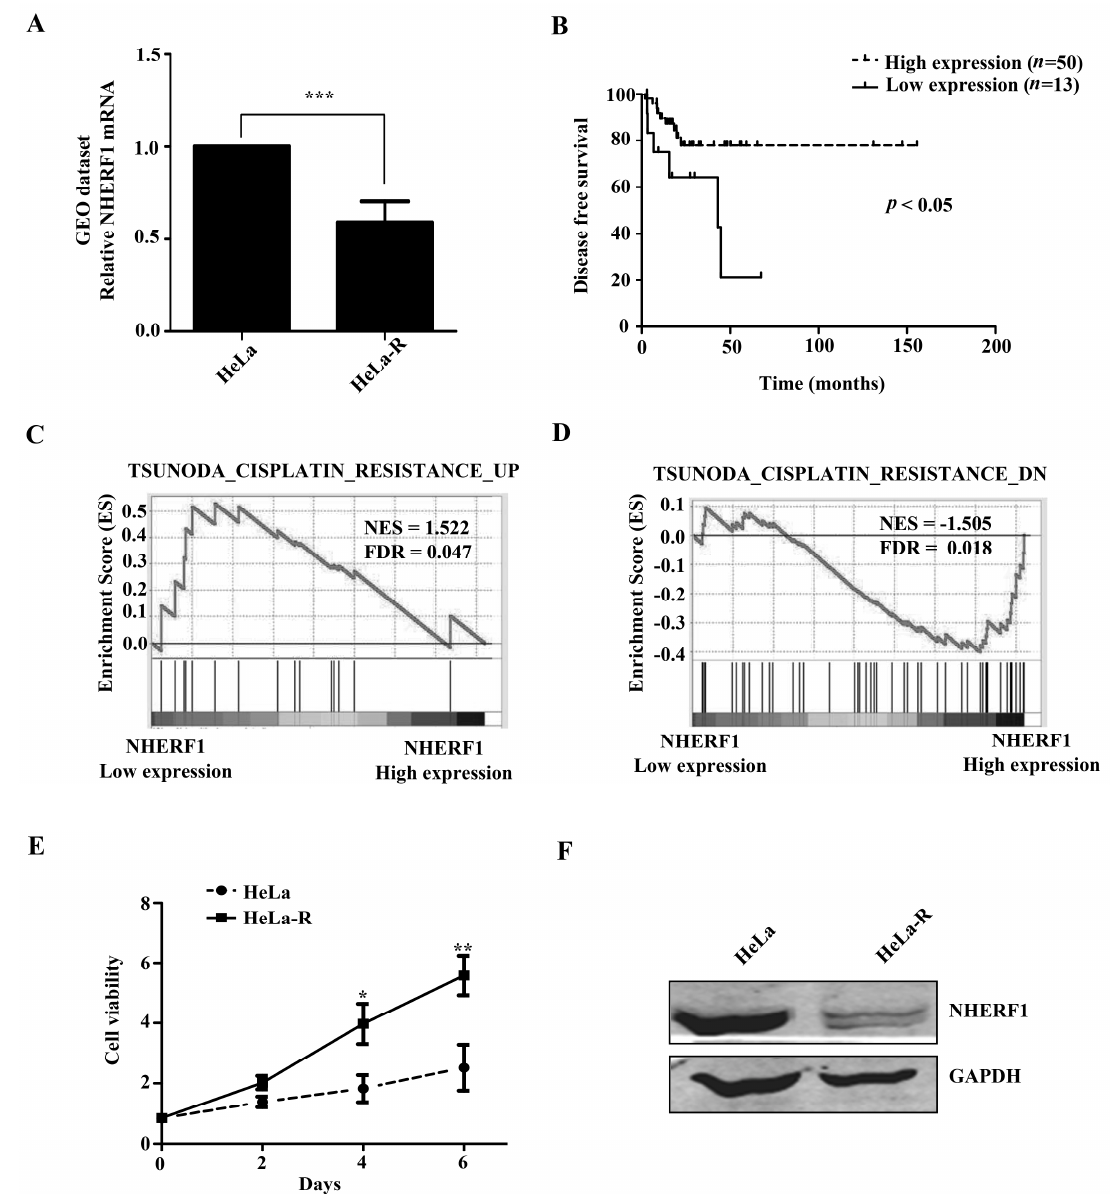
Figure 1. Na + /H + Exchanger Regulatory Factor 1 (NHERF1) is downregulated in cisplatin-resistant cervical cancer HeLa cells. ( A ) NHERF1 gene expression in parental and cisplatin-resistant cervical cancer cells was analyzed based on dataset GSE15120. Data are expressed as fold change compared to parental cells. Results represent the mean ± SD of six samples. *** p < 0.001 with respect to parental cells; ( B ) Kaplan-Meier survival analysis of 63 patients with cisplatin treatment in a cervical cancer dataset from TCGA. These patients were divided into high ( n = 50) and low ( n = 13) NHERF1 expression groups; ( C , D ) GSEA analysis of cervical cancer TCGA dataset based on signatures of cisplatin resistance up-regulated genes ( C ) and cisplatin resistance down-regulated genes ( D ) according to NHERF1 mRNA expression levels; ( E ) Establishment of cisplatin-resistant HeLa cells. Parental and cisplatin-resistant HeLa cells were cultured in the presence of 1.0 μ g/mL cisplatin in 96-well plates and stained with cell counting kit-8 (CCK8) at indicated time. Values are presented relative to cell viability on day 0. * p < 0.05, ** p < 0.01 compared with the parental cells; ( F ) Western blotting analysis of NHERF1 expression in parental and cisplatin-resistant HeLa cells. In ( A ), ( E ), and ( F ), HeLa-R, cisplatin-resistant HeLa cells.